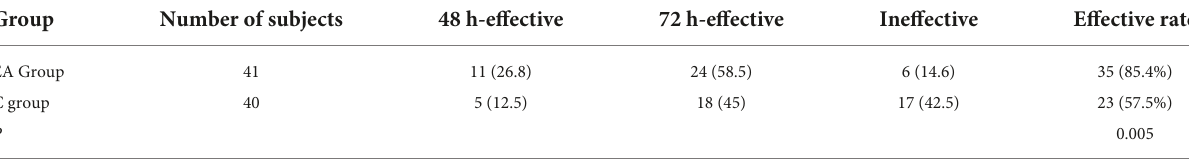
TABLE 2 Comparison of clinical efficacy of stress ulcer (SU) treatment between the two groups [(n) %].